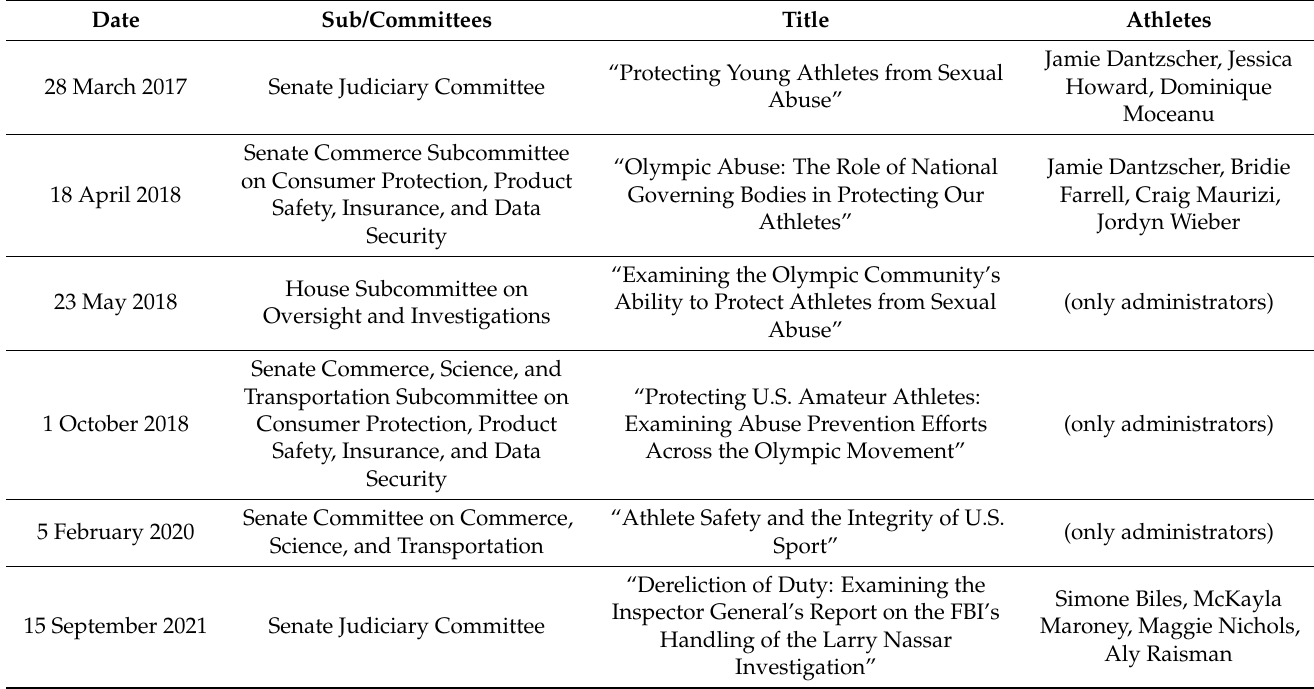
Table 3. Congressional Hearings on Sexual Abuse in Sport,